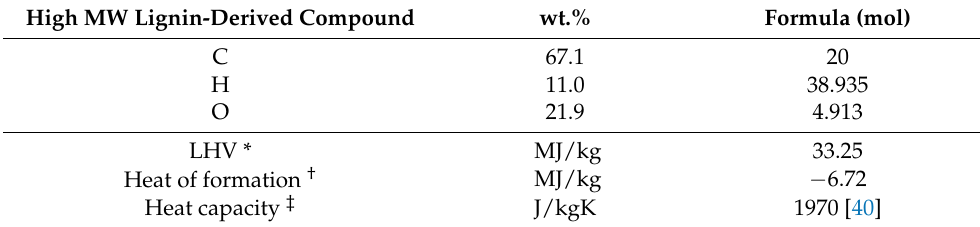
Table 5. Properties of the high molecular weight lignin-derived compounds